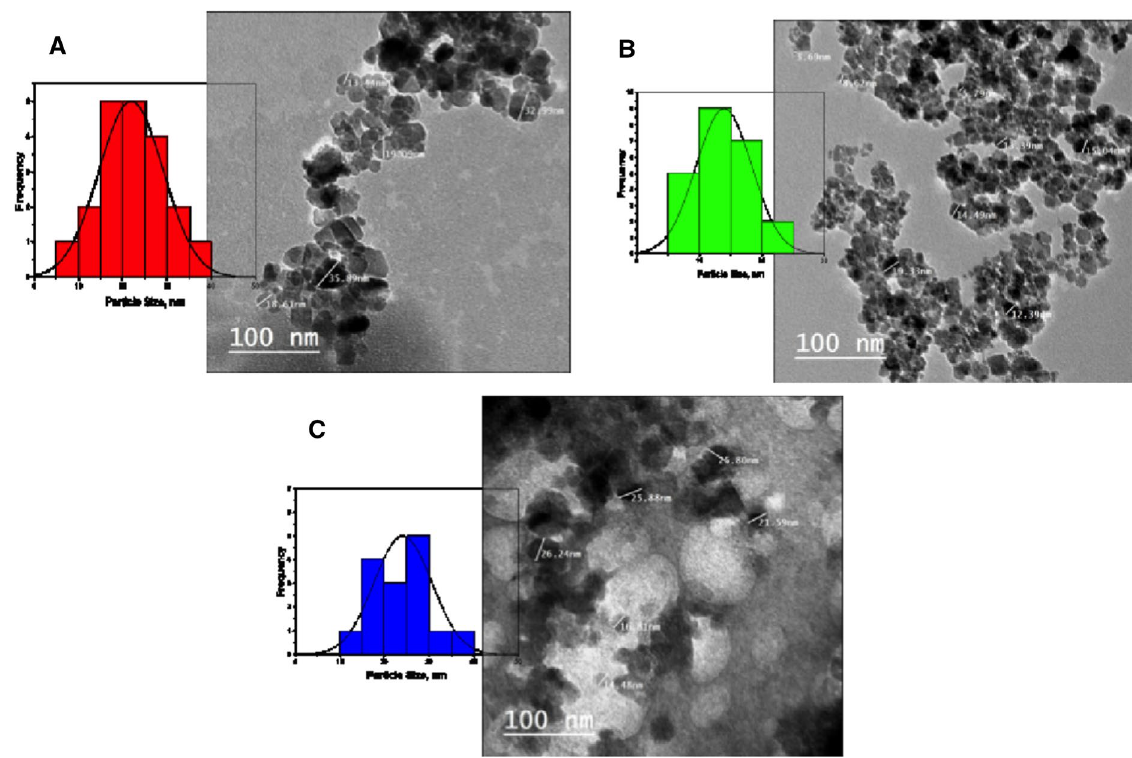
Fig. 3 TEM micrograph augmented with the particle size distribution histograms of the synthesized CS-M/Fe rial A CS-M-(2:1), B CS-M-(1:2) and C CS-M-(3:1)